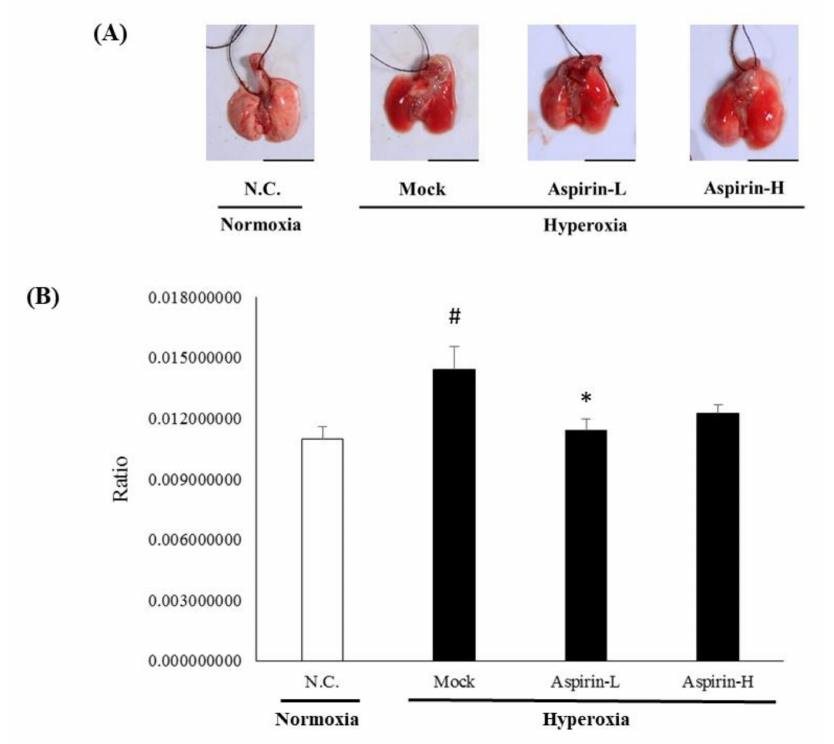
Figure4. ( A )Gross appearanceof lungand ( B )lung wet-to-dryweight ratioanalysis inNF- κ B–luciferase transgenic mice after the induction of hyperoxia for 72 h in the normal control (NC), mock, aspirin-L and aspirin-H groups. The reported values are expressed as the mean ± SEM ( n = 6). # p < 0.05 vs. NC group. * p < 0.05 vs. mock group.